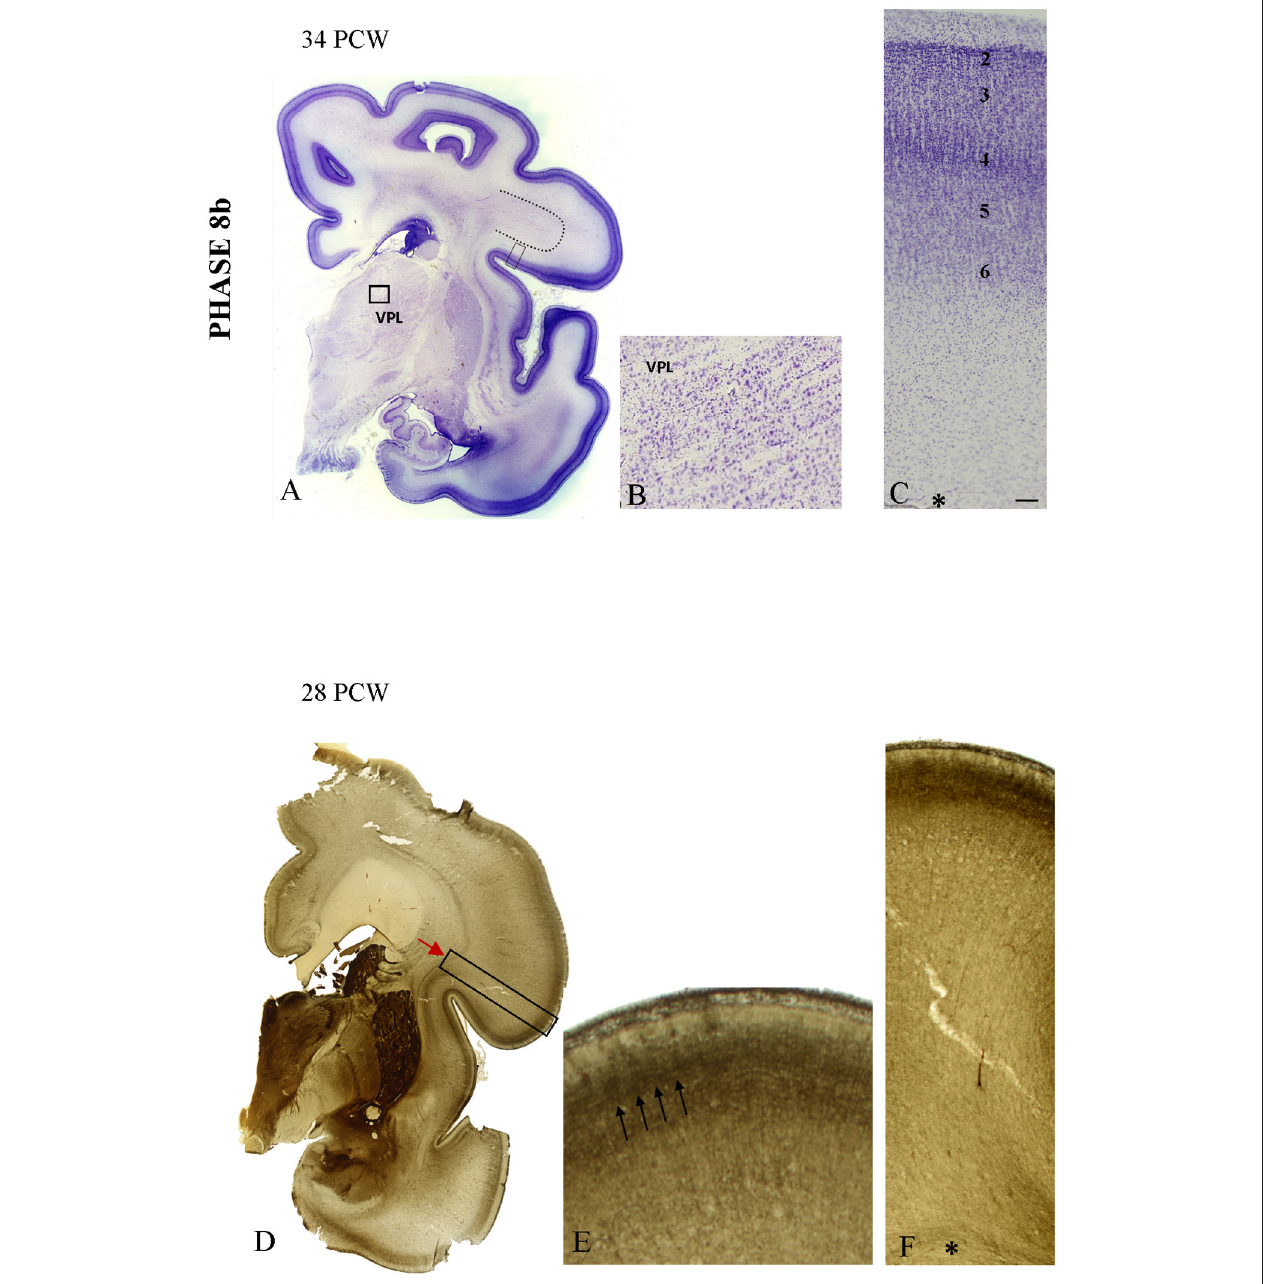
FIGURE 8 | The appearance of the initial prospective 6-layered pattern on Nissl preparation at 34 PCW (A,C). The border between the developing gyral white matter and SP became obscured (dotted line on A ) due to radial arrangement of fibers. The advanced cytoarchitectonic differentiation of the VPL territory is shown on (B) . (D–F) The increase in elaboration of AChE activity in the form of the uneven pattern suggestive of the vertical banding at 28 PCW. On (E) three AChE reactive strata are seen: superficially in the MZ, in the middle of the CP and the deep interface of SP and CP. The middle band shows uneven staining in both tangential and radial direction, suggestive of vertical patterning (arrows). Asterisk marks border between SP and fiber strata of intermediate zone. Scale bar: 100 µ m.